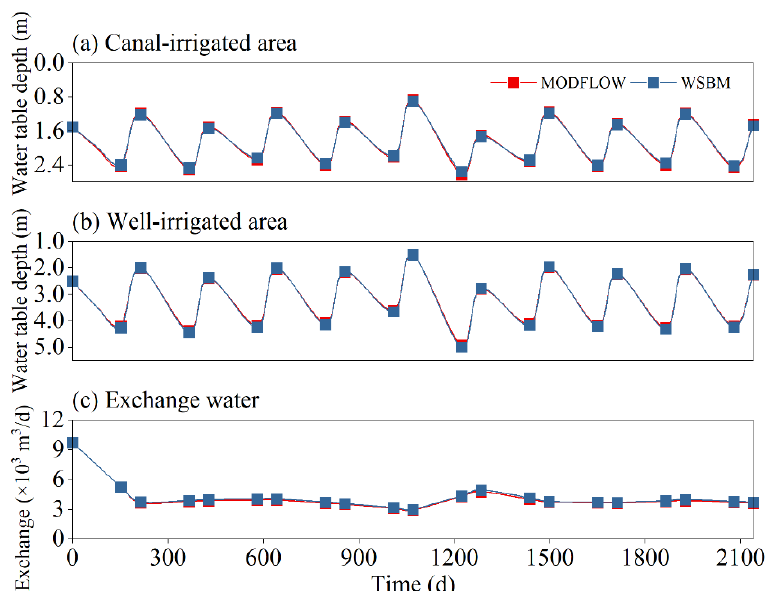
Figure 5. Comparison of simulated water table depths and exchange volume between the canal- irrigated area and the well-irrigated area by the developed model and MODFLOW.